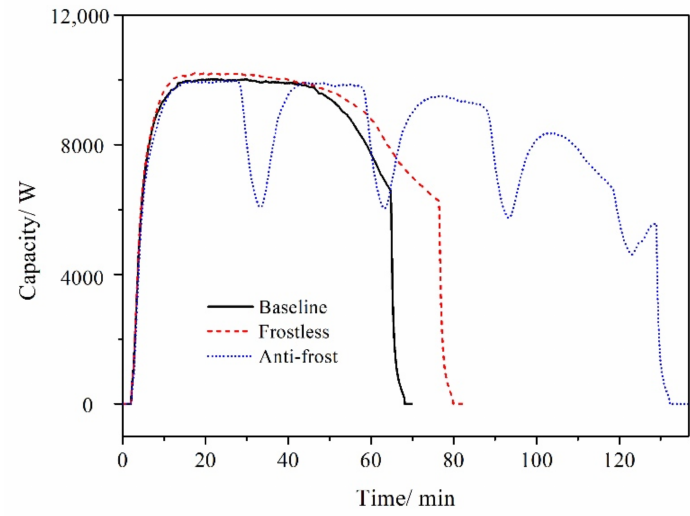
Figure 7. Heating capacity of the ASHP for the three modes.